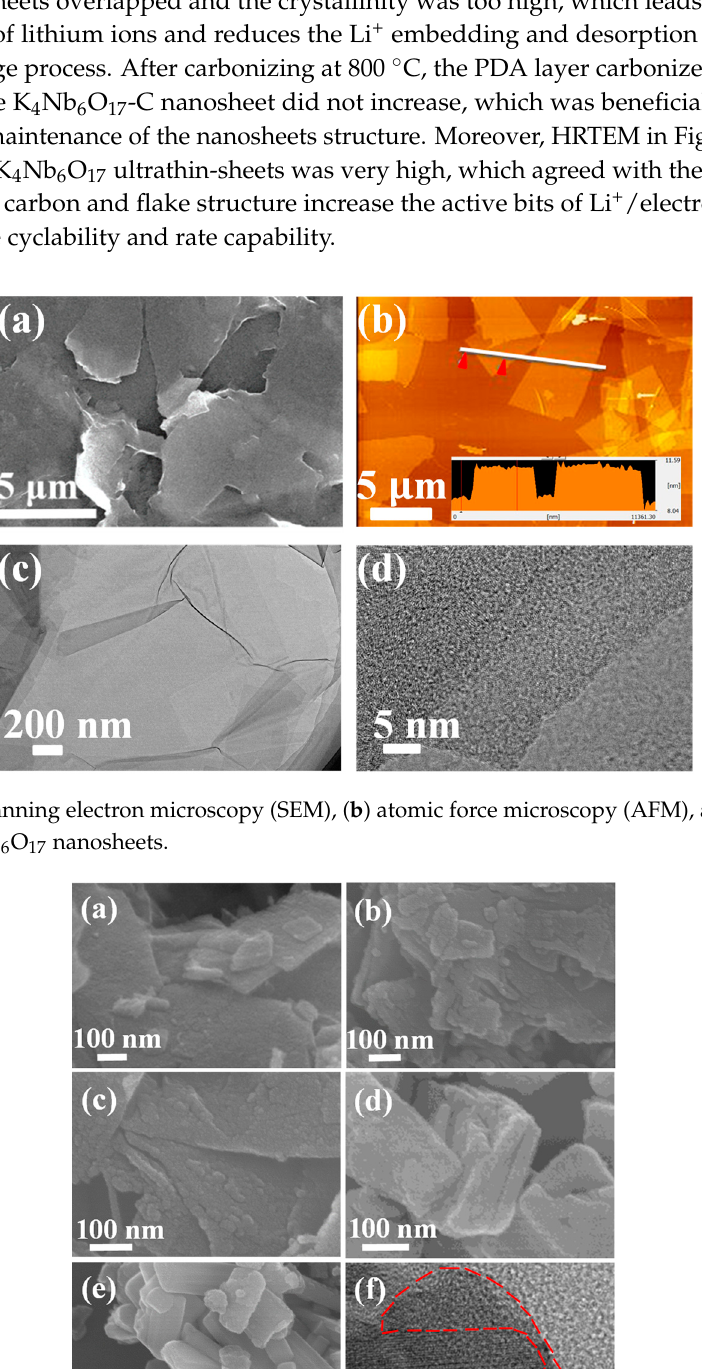
Figure 2. ( a ) Scanning electron microscopy (SEM), ( b ) atomic force microscopy (AFM), and ( c , d ) TEM images of K 4 Nb 6 O 17 nanosheets. Figure 1. ( a ) X-ray diffractometer (XRD) spectra of K 4 Nb 6 O 17 crystal and K 4 Nb 6 O 17 nanosheets. Inset was the optical photograph (left) and SEM image (right) of K 4 Nb 6 O 17 crystal. ( b ) Zeta potential of